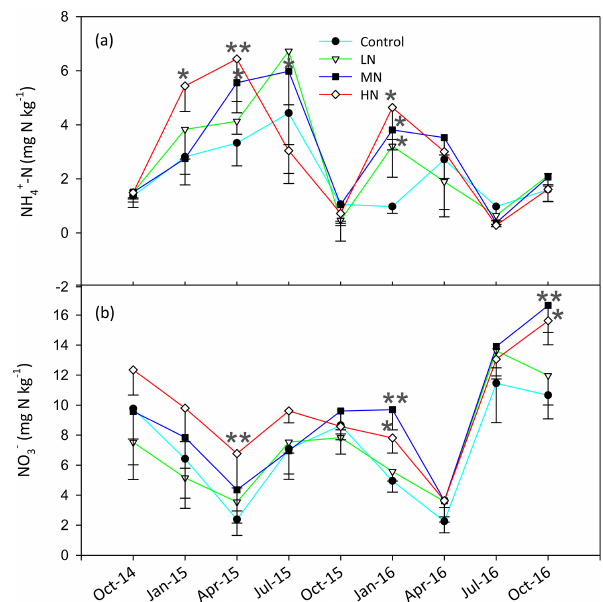
Figure 1. Changes in soil NH + the soils at different samplings. Bars represent standard errors of the mean ( n = 3). Significance levels are indicated by ∗ P < 0 . 05, ∗∗ P < 0 .